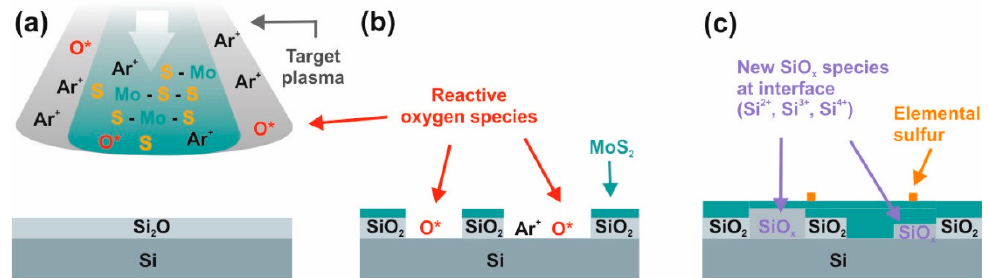
Figure 6. Schematic illustration of interfacial reactions in case of IJD-MoS 2 on SiO 2 / Si substrate: ( a ) before ionized jet deposition; ( b ) initial etching of the SiO 2 native oxide; ( c ) formation of complex SiO x surface and MoS 2 thin film